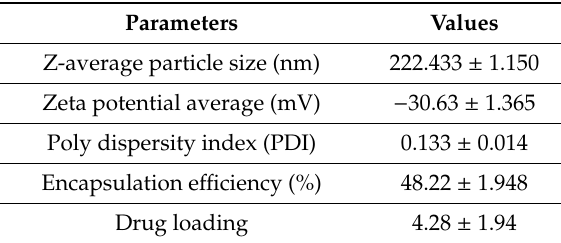
Table 1. Physical-chemical characterization of drug-loaded BSA NPs